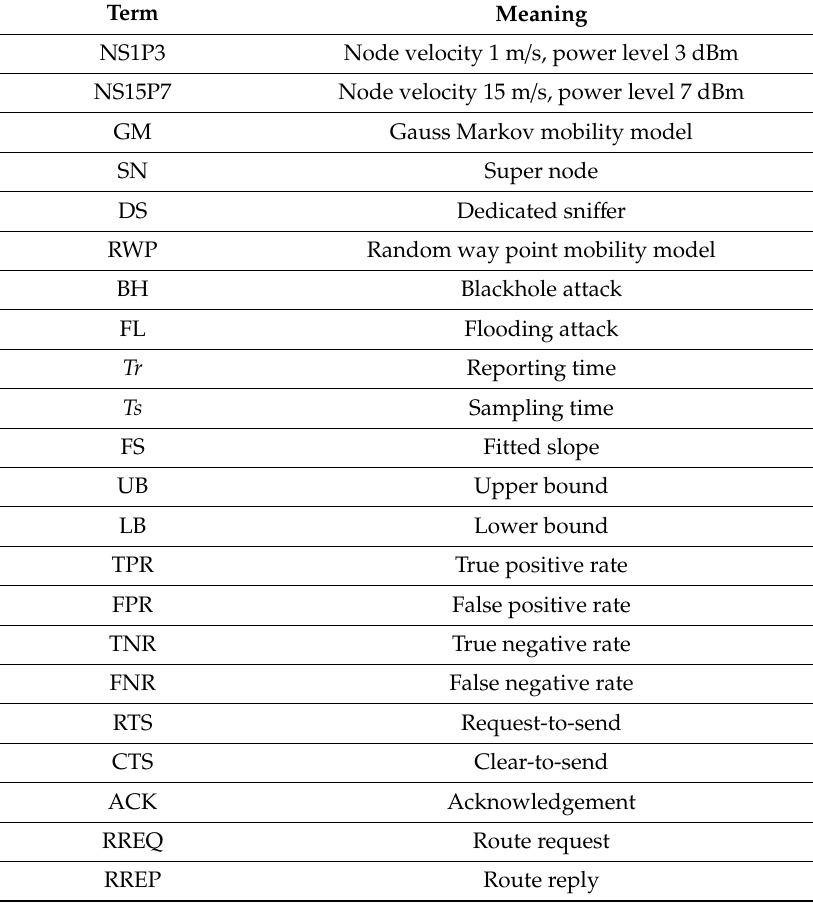
Table A1. List of abbreviations mentioned in this